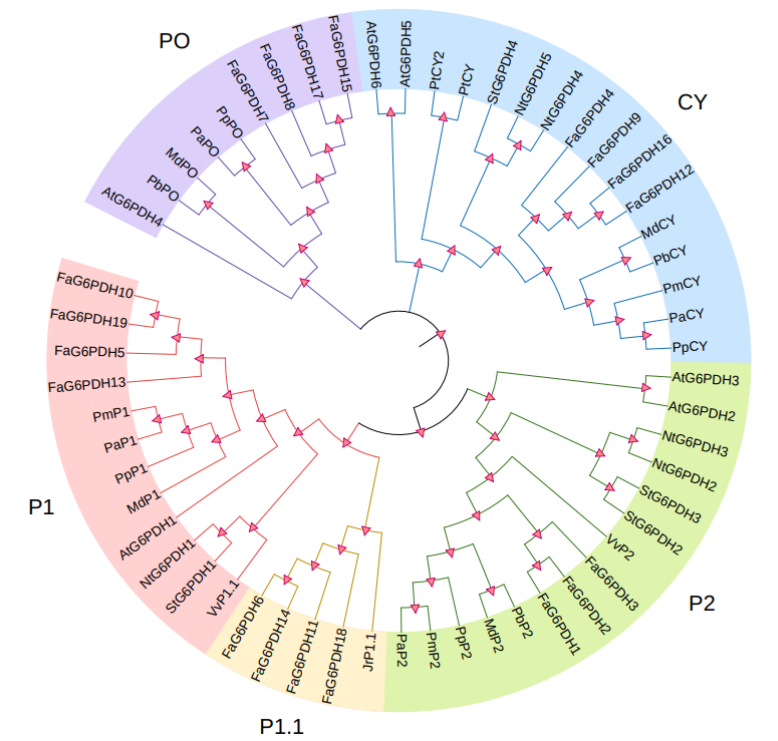
Figure 3. Phylogenetic analysis of FaG6PDHs. Five subgroups are shown as CY, P1, P1.1, P2, and PO according to the five known subgroups in